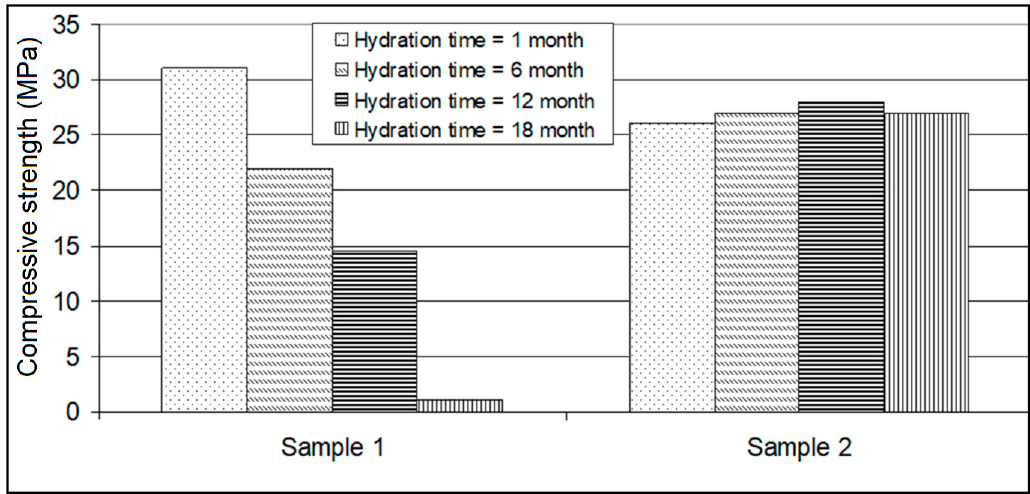
Figure 14. Compressive strength values for samples 1 and 2.